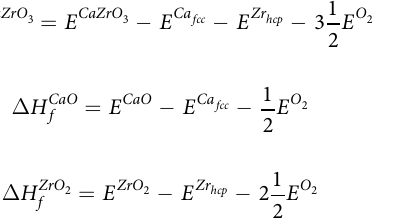
atom, 0.016 Å 3 /atom, 0.006 Å 3 /atom, 0.032 Å 3 /atom and 0.007 Å 3 /atom for CZO, CaO, ZrO 2 , fcc Ca and hcp Zr,